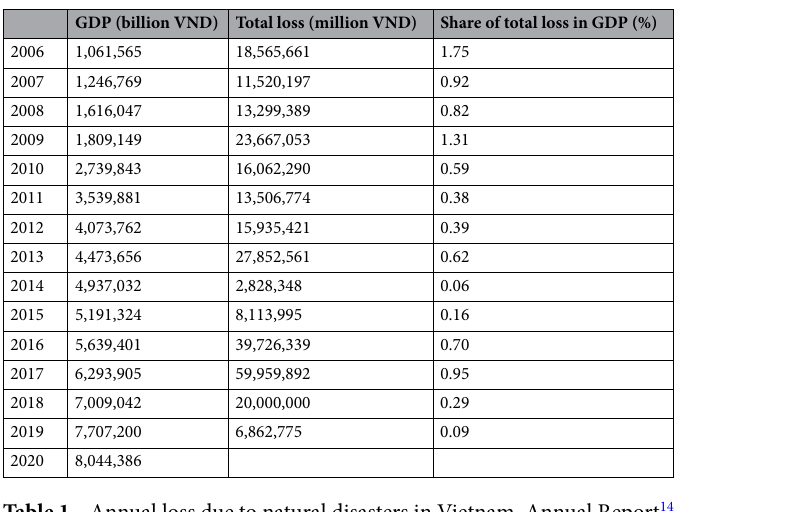
Table 1. Annual loss due to natural disasters in Vietnam. Annual Report 14